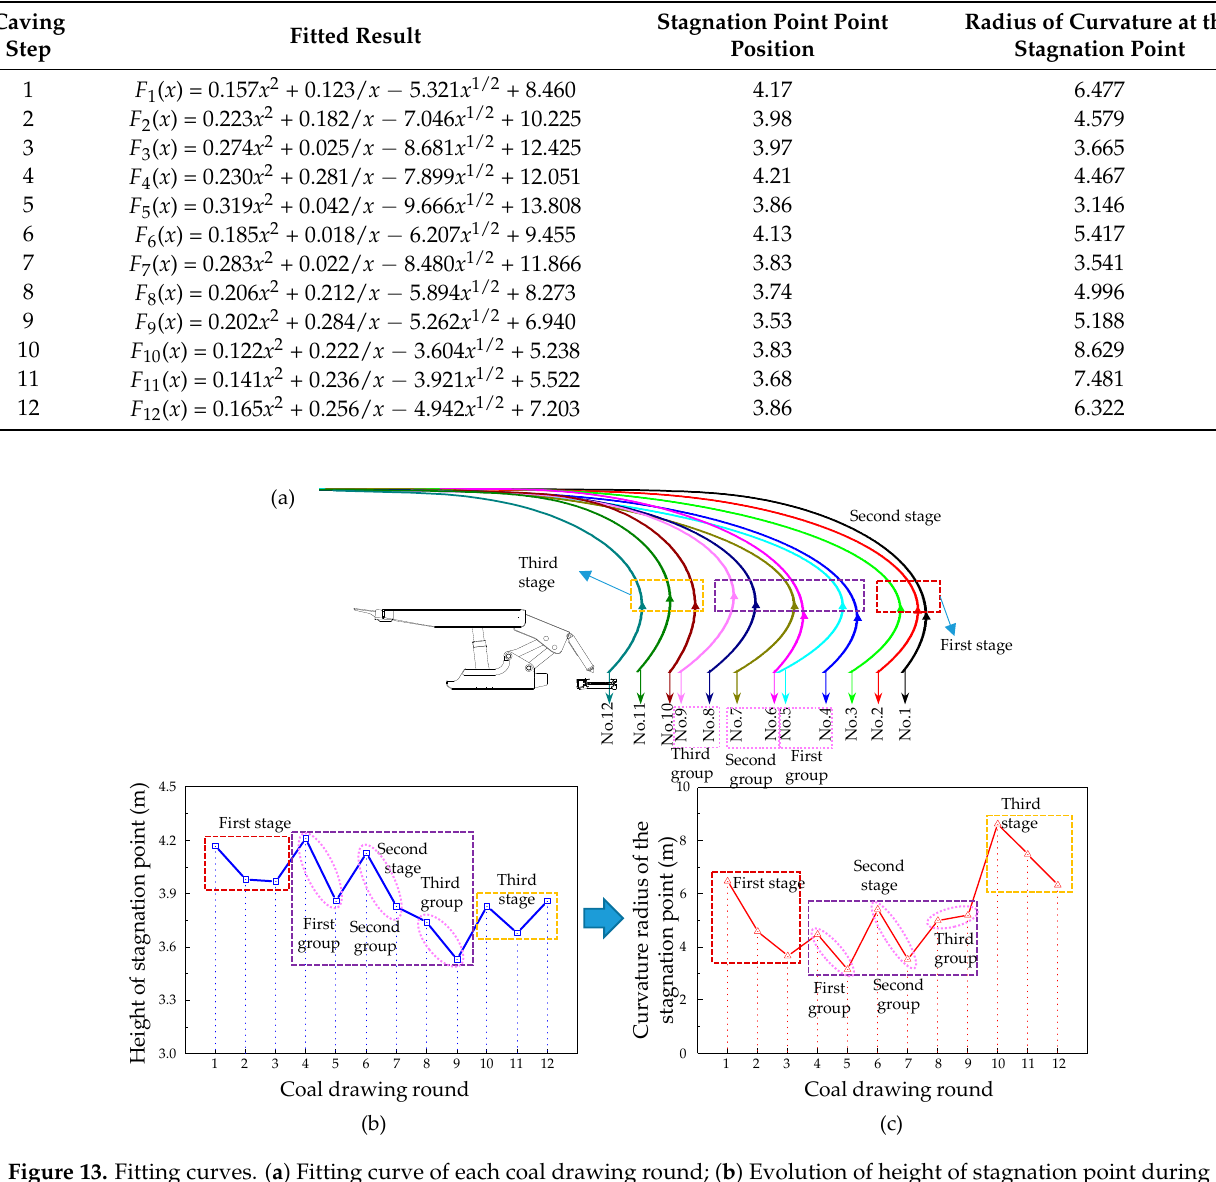
Table 4. Fitting parameters.